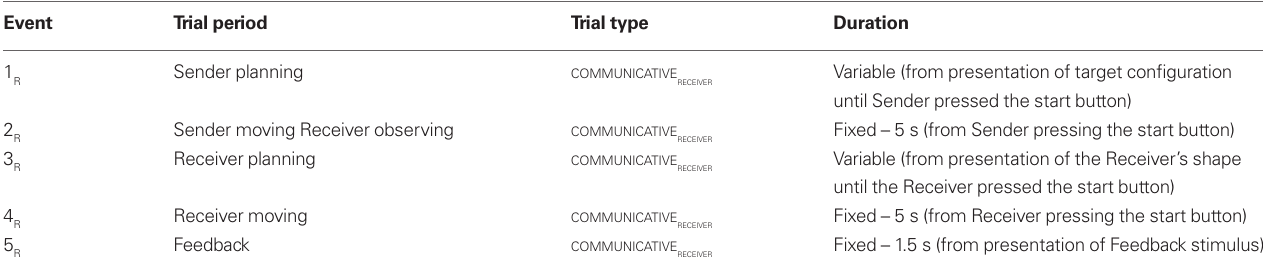
Table 2 | The fi ve events and durations defi ned for the communicative